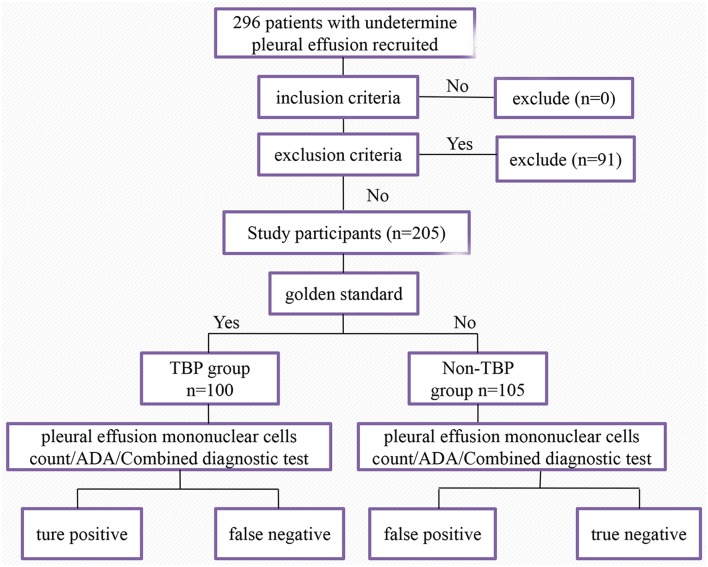
Flowchart of the study population. A total of 296 patients with undetermined pleural effusion were recruited initially. Two hundred and five patients were included in the final analysis.